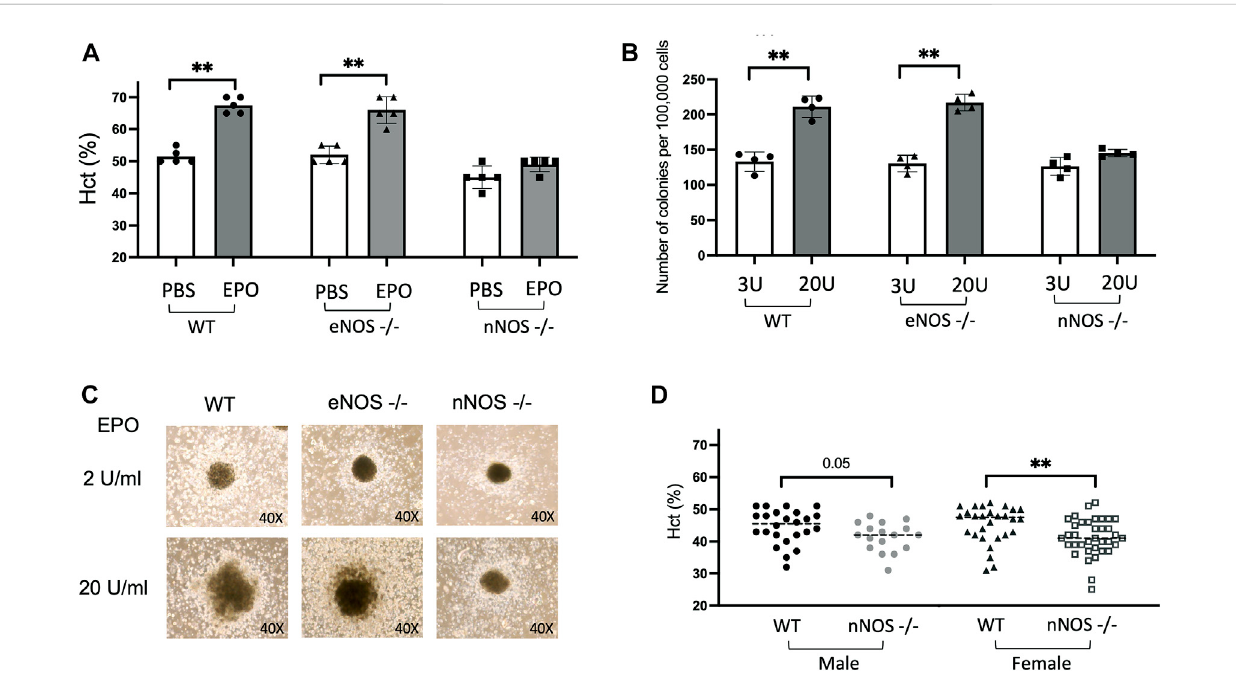
FIGURE 1 EPOstimulatederythropoiesisin nNOS − / − mice. nNOS − / − miceshowedabluntederythropoieticresponsetoEPOwhileerythropoieticresponsein eNOS − / − mice was comparable to WT. (A) Hematocrit levels (%) in WT, eNOS − / − , and nNOS − / − mice were determined after 10 days of EPO treatment (3000 U/kg; 3 times per week). (B) Methylcellulose hematopoietic colony-forming assays were carried out using bone marrow hematopoietic cells from WT, eNOS − / − ,and nNOS − / − miceandmethylcellulose-basedmediasupplementedwithhematopoieticgrowthfactors,EPOat3 U/mLor20 U/mL, and scored for total hematopoietic colonies after 14 days. (C) Photographs of CFU-granulocyte, erythroid, macrophage, megakaryocyte (CFU-GEMM) colonies derived from bone marrow hematopoietic cells cultured with EPO at 2 U/mL or 20 U/mL from WT, eNOS − / − and nNOS − / − mice (40X).